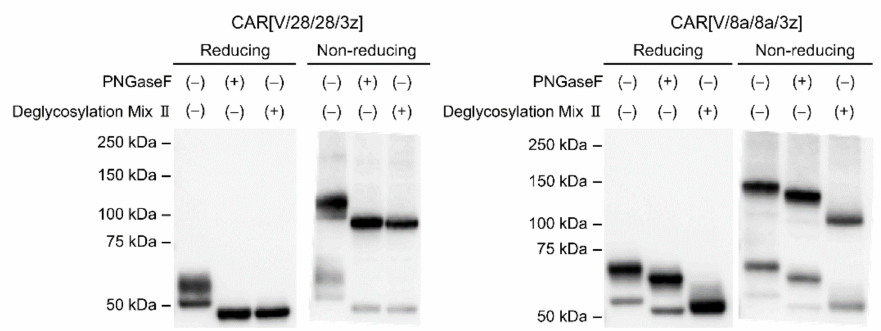
Figure 1. Analysis of cysteine-mediated disulphide bonds and glycosylation in the HD of CAR[V/28/28/3z] and CAR[V/8a/8a/3z]. SDS-PAGE and Western blotting analysis showing the expression of two CARs in whole CAR-T cell lysate on day 0 (24 h after transduction).